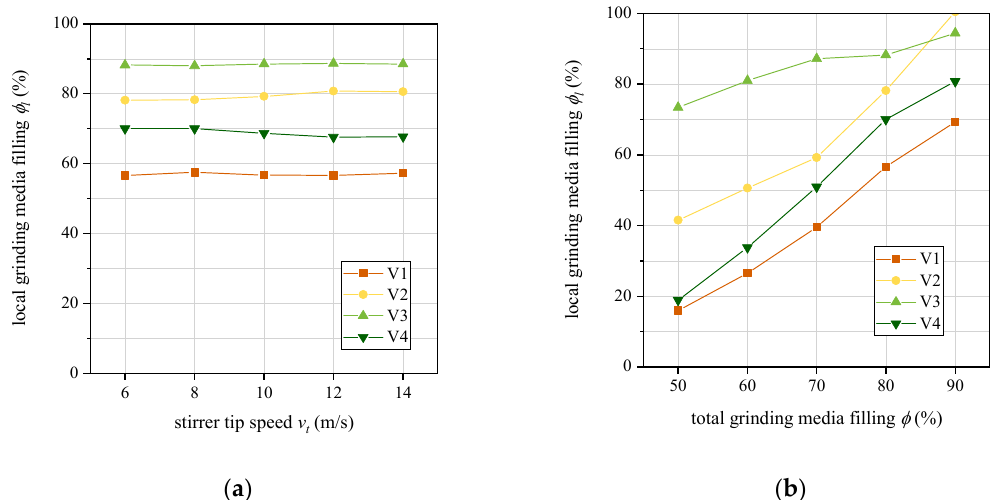
Figure 4. Local filling level in the individual volumes V1–V4 for: ( a ) varied stirrer tip speeds; ( b ) varied total filling